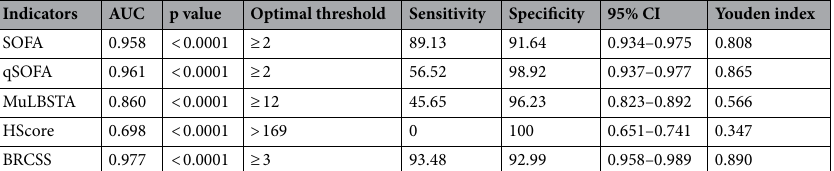
Table 5. Evaluation of the sensitivity and specificity of the scoring systems according to the cut-off values in literature. SOFA Sequential organ failure assessment score, qSOFA quick sequential organ failure assessment score, MuLBSTA multilobularinfiltration, hypo-lymphocytosis, bacterial coinfection, smoking history, hyper- tension and age score, HScore hemophagocytosis score, BRCSS Brescia respiratory covid severity scale.